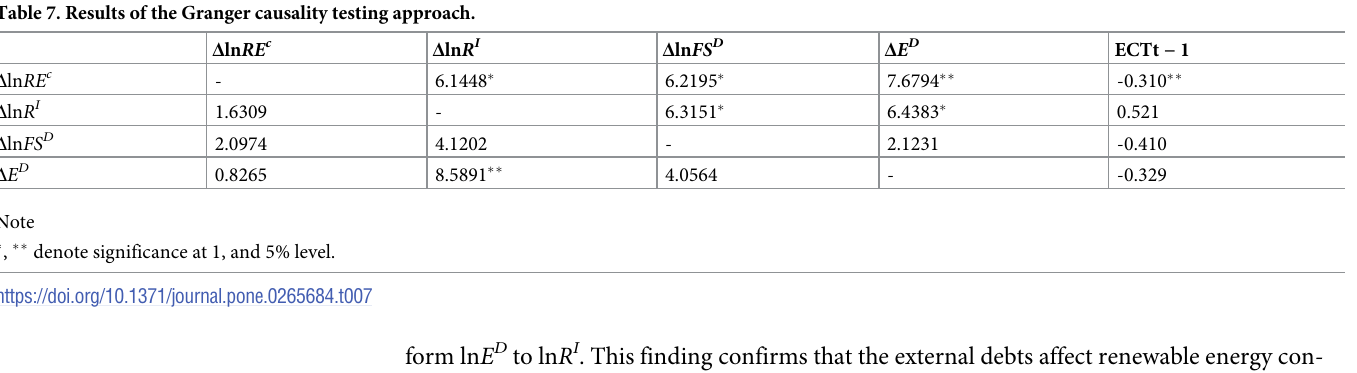
Table 7. Results of the Granger causality testing approach.